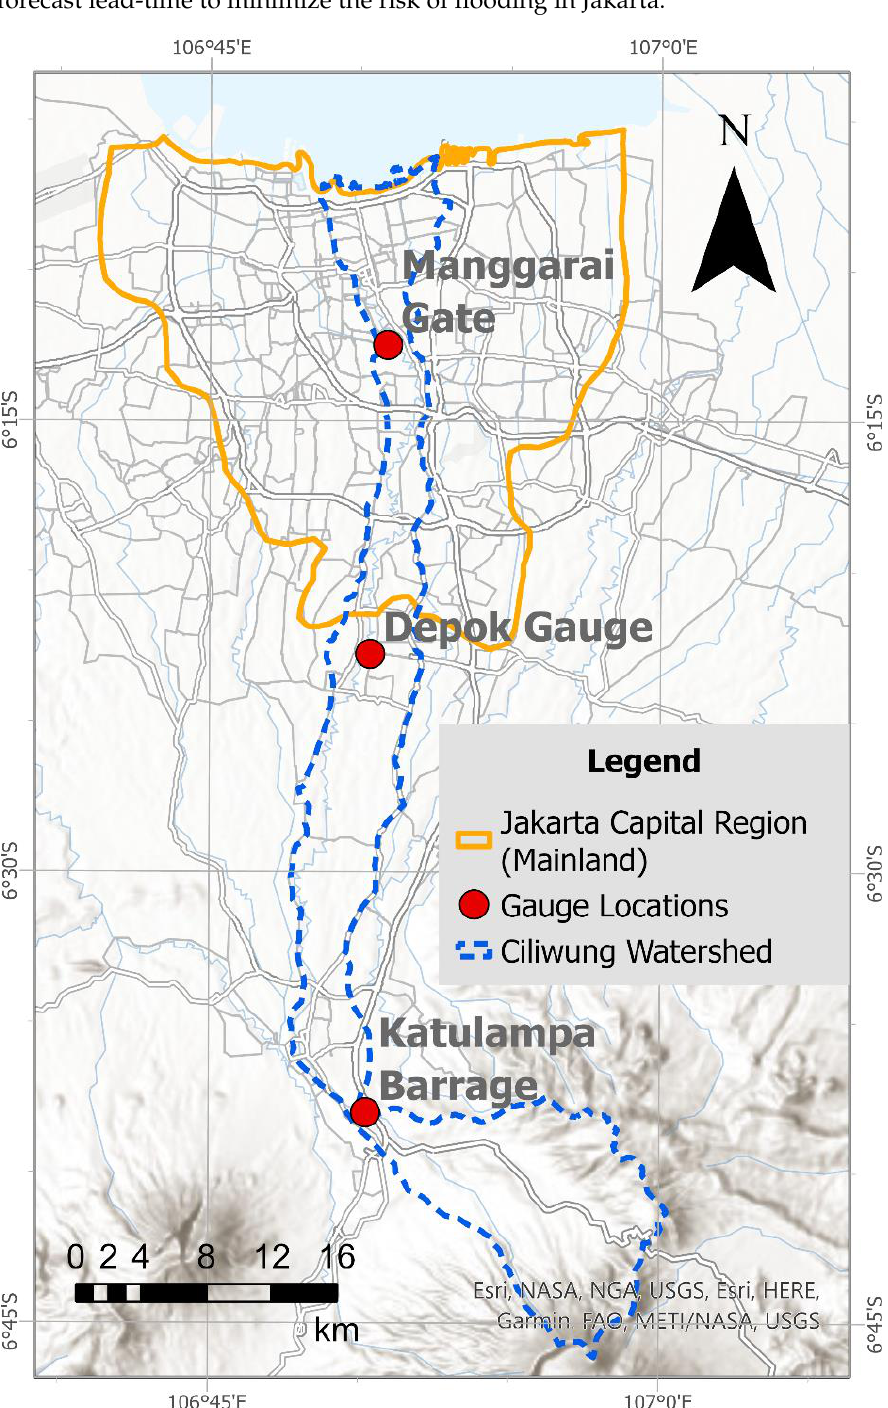
Figure 1. Study area orientation and the general conveyance time between point of interests; observed peak water level at Katulampa Barrage would reach Manggarai gate within 13–14 h, which is at the very heart of the Jakarta Capital Region. Table 1. Comparison between data source and target output variables in the resect publications in the field of machine learning-based flood prediction research. The shaded cells denote the same datatypes used for prediction source and output.